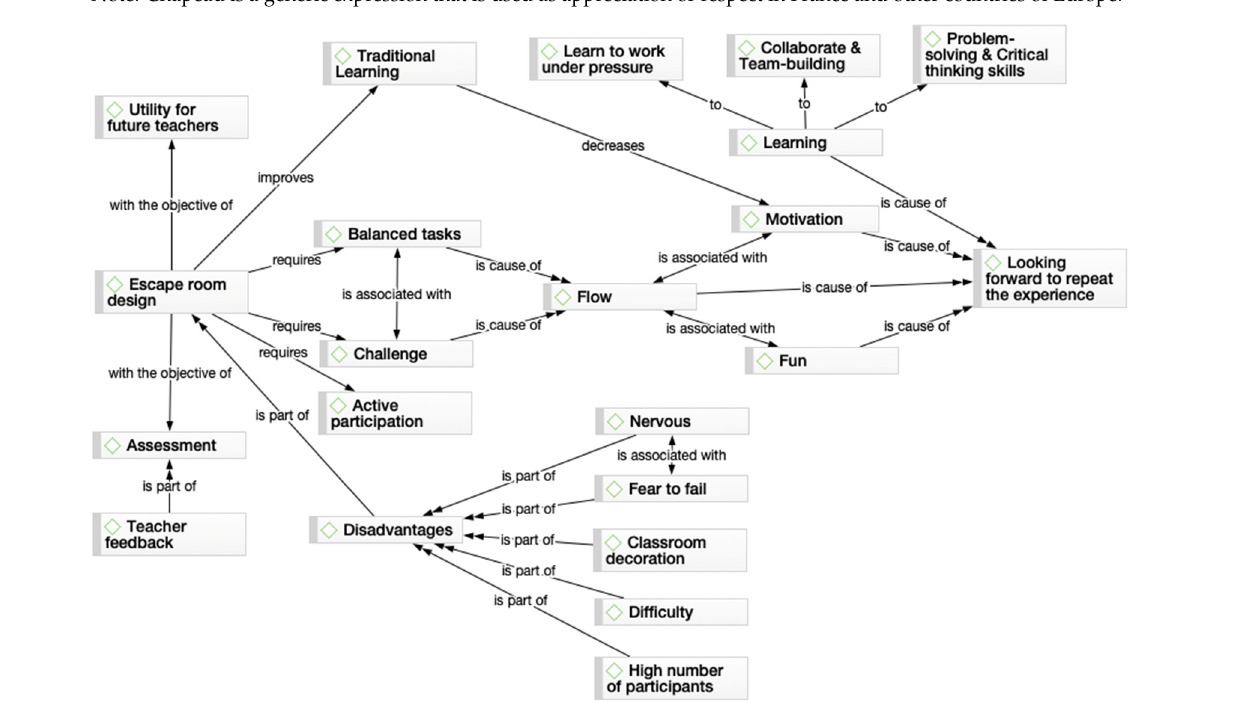
Figure 2. Network diagram of student ’ s experiences about the educational escape room .